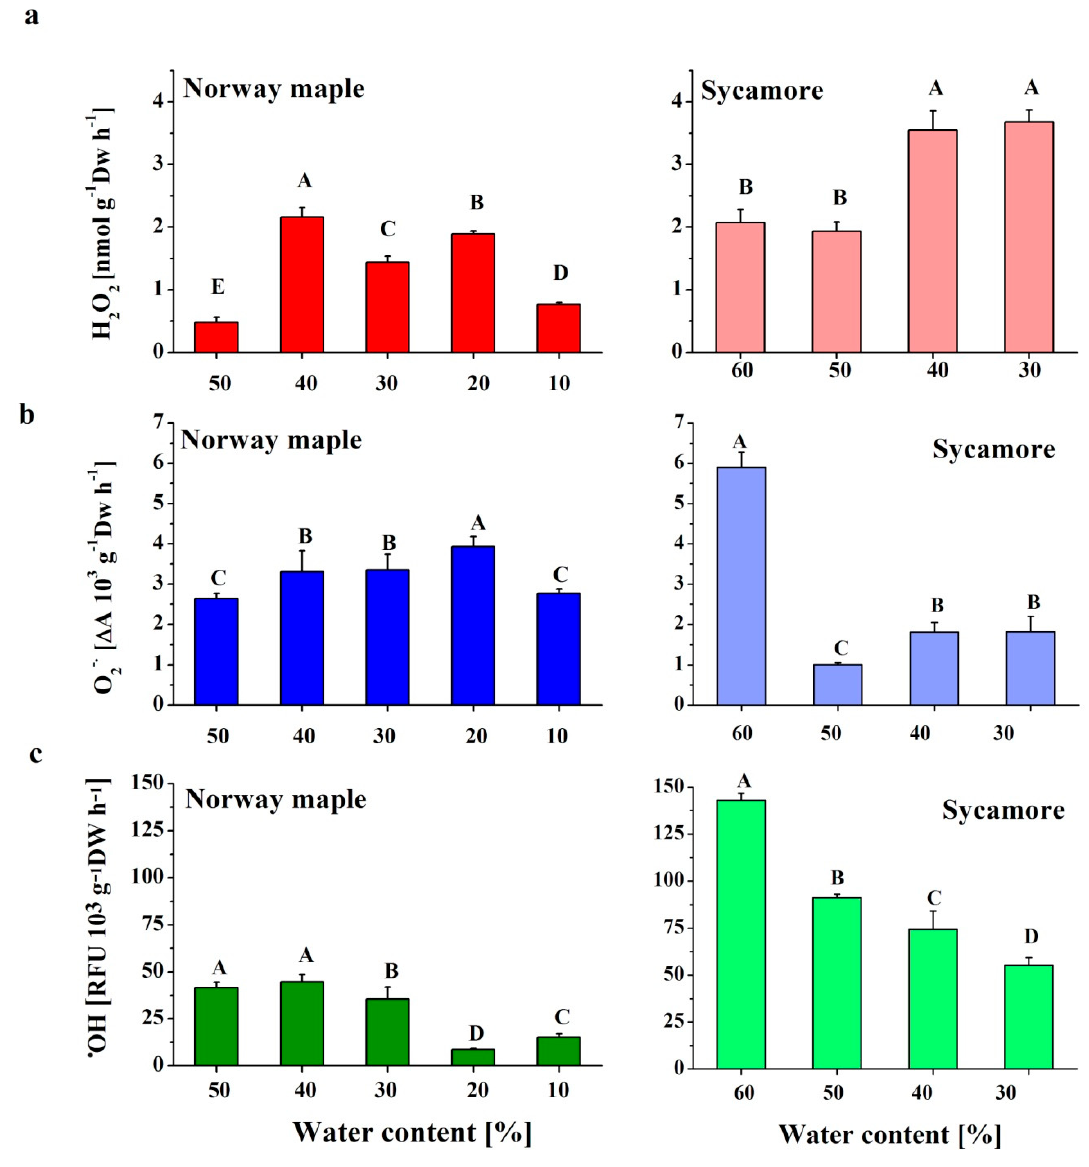
Figure 1. Detection of the ROS levels ( a ) hydrogen peroxide (H 2 O 2 ), ( b ) superoxide anion radical (O 2 • − ) and ( c ) hydroxyl radical (•OH) in Norway maple seeds desiccated to 10% WC and in sycamore seeds dehydrated to 30% WC. The data are the means of six independent replicates ± the STDs. The same letters indicate groups that are not significantly different according to Tukey’s test.